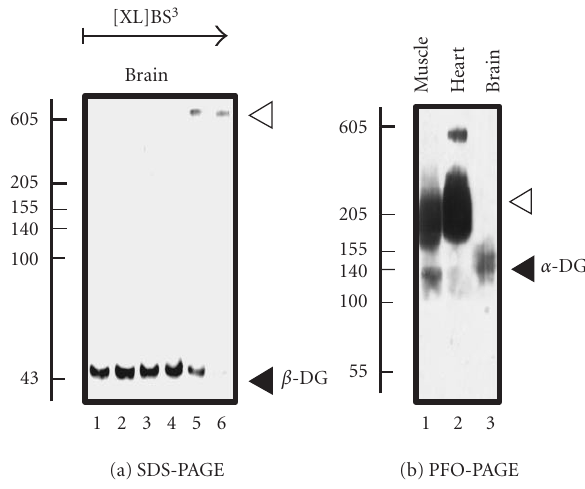
Figure 2. Analysis of the brain dystroglycan complex. Panel (a) shows the chemical cross-linking analysis of β -dystroglycan ( β -DG) of apparent 43 kd in normal mouse brain using the hydrophilic probe bis-sulfosuccinimidyl- suberate (BS 3 ) and sodium dodecyl sulfate polyacrylamide gel electrophore- sis (SDS-PAGE). Detection of this sarcolemmal protein was achieved by immuno-decoration with monoclonal antibody NCL-b-DG [10]. Lanes 1–6 represent 0, 25, 50, 100, 200, and 300 µ g BS 3 /mg protein, respec- tively.Increasingconcentrationsofcrosslinker(XL)clearlystabilizedahigh- molecular-mass complex demonstrating the oligomeric status of brain β - dystroglycan. In panel (b), is shown the perfluoro-octanoic acid polyacry- lamide gel electrophoresis (PFO-PAGE) [9] analysis of α -dystroglycan ( α - DG). Lanes 1 to 3 represent mouse skeletal muscle, cardiac muscle, and brain microsomal membranes, respectively. The highly glycosylated, extra- cellular protein α -dystroglycan was immuno-decorated employing mono- clonal antibody VIA1 2 [10]. Compared to skeletal and cardiac muscle, the dystroglycan sub-complex was not preserved in brain by this method, indi- cating a more tentative dystroglycan binding in the central nervous system. The position of monomers and oligomers is marked by closed and open ar- row heads, respectively. The relative position of molecular mass markers (in kd) is indicated on the left of blots.